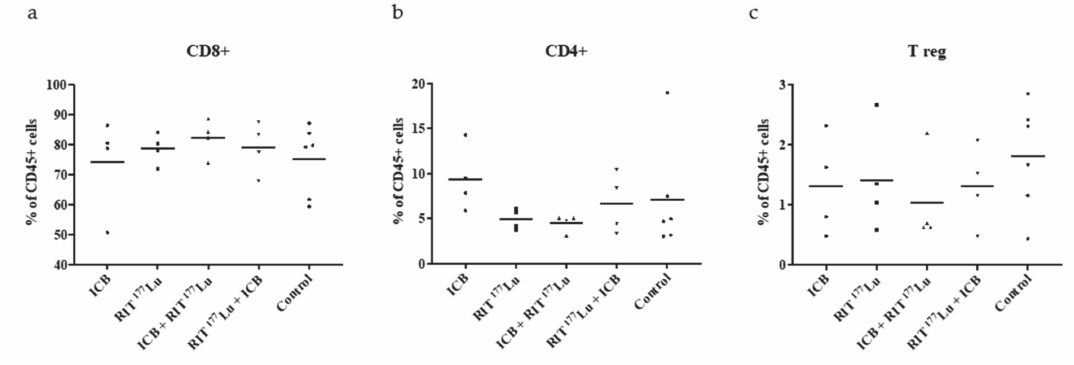
Figure 7. Flow cytometry data for determination of tumor-infiltrating T cells for possible synergistic e ff ects between anti-PD1 and 177 Lu-h8C3 antibody. Groups of four tumor-bearing mice (three treatments of anti-PD1), single injection of 177 Lu, three treatments of anti-PD1 followed by one treatment of 177 Lu-8hC3, and one treatment of 177 Lu-h8C3) or six mice (control) were treated and sacrificed on day 20. Tumors were harvested and analyzed by ( a ) comparing % of CD8 + cells among CD45 + cells, ( b ) comparing % of CD4 + cells among CD45 + cells, and ( c ) comparing % of Treg + cells among CD45 +/ CD4 +/ foxP3 + cells for each cohort. Each data point represents one animal in each group. No significance was found in any treatment group relative to